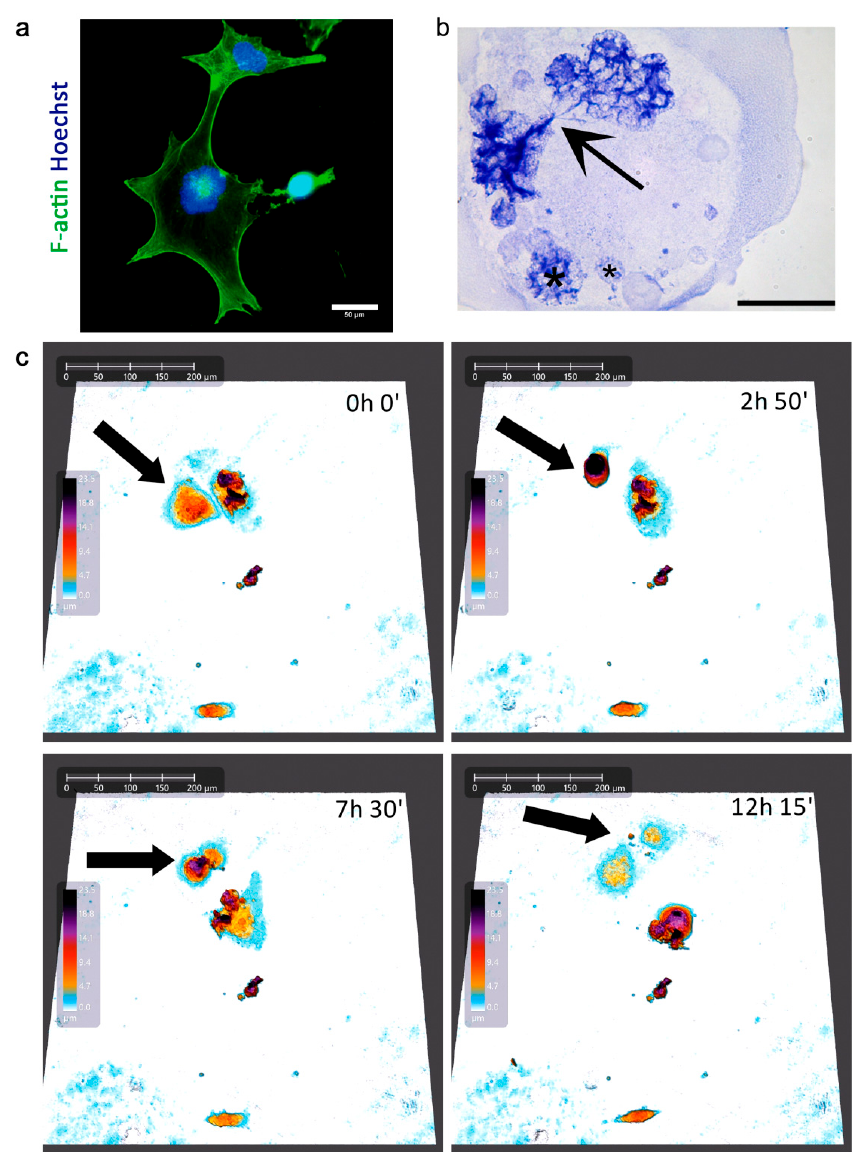
Figure 4. Depolyploidization of a giant senescent MDA-MB-231 cell. Cells were treated with 100 nM doxorubicin for 24 h, then cultured in a fresh medium and analyzed on subsequent days. ( a ) Intermediate state of asymmetric division. Cells were stained for F-actin (green), nuclei were stained with Hoechst (blue). Scale bar: 50 µ m. ( b ) Multinucleated polyploidy cell with incomplete mitosis, daughter subnuclei remain linked by a series of chromosome bridges (arrow), smaller interphase nuclei marked with a star (*). Toluidine blue staining at pH 4 after shortened acid hydrolysis. Scale bar: 50 µ m. ( c ) Time lapse of asymmetric division of polyploid giant cancer cell on day D1 + 7, documented with holographic microscope.